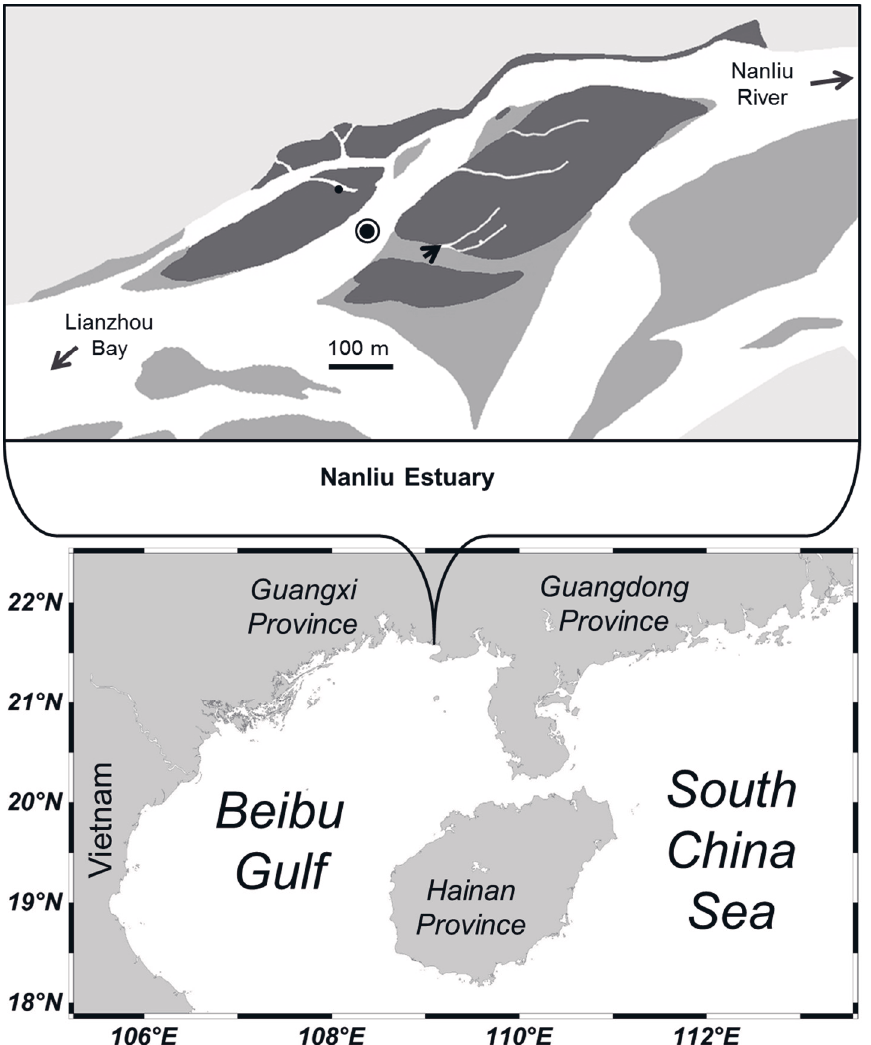
Figure 1. Studied mangrove site in the Nanliu River Estuary. Dark gray areas are mangrove forest, medium gray areas are low intertidal sand banks, the small black dot shows the sediment core sampling site, the concentric symbol shows the tidal sampling site (21°37 ′ 6.85 ′′ N, 109°1 ′ 40.15 ′′ E), and a small black arrow indicates the mangrove effluent sampling site. Up- and downriver directions are indicated by black arrows. For a more detailed map of the estuary see